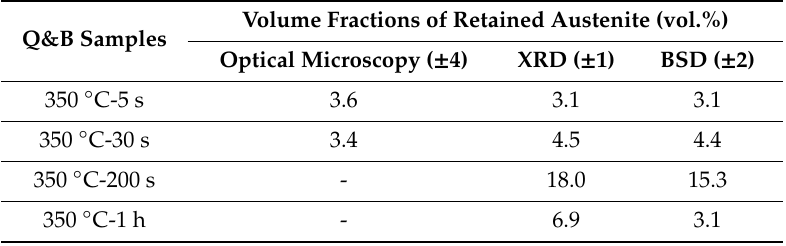
Table 3. The variation in volume fractions of retained austenite taken from Q&B heat-treated samples determined by di ff erent analyzing